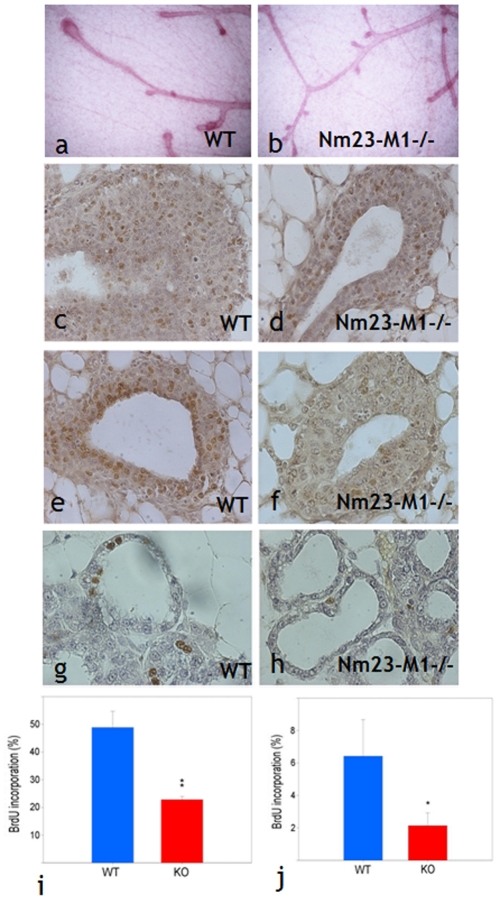
Lack of nm23-M1 results in impaired proliferation.Whole mounts of WT (a) and nm23-M1−/− (b) mammary glands show a delayed growth of the TEBs in the mutant glands (original magnification X5). BrdU incorporation (brown nuclei) was evidenced in sections from mammary glands from 6 weeks old WT (c,e) or nm23-M1−/− (d,f) virgin females and L1 WT (g) or L1 nm23-M1-/- (h) lactating females (original magnification X400). Quantifications in virgin glands (i) and lactating glands (j) revealed a drop in BrdU incorporation in the epithelial cells of the mutant glands. KO: nm23-M1−/−.